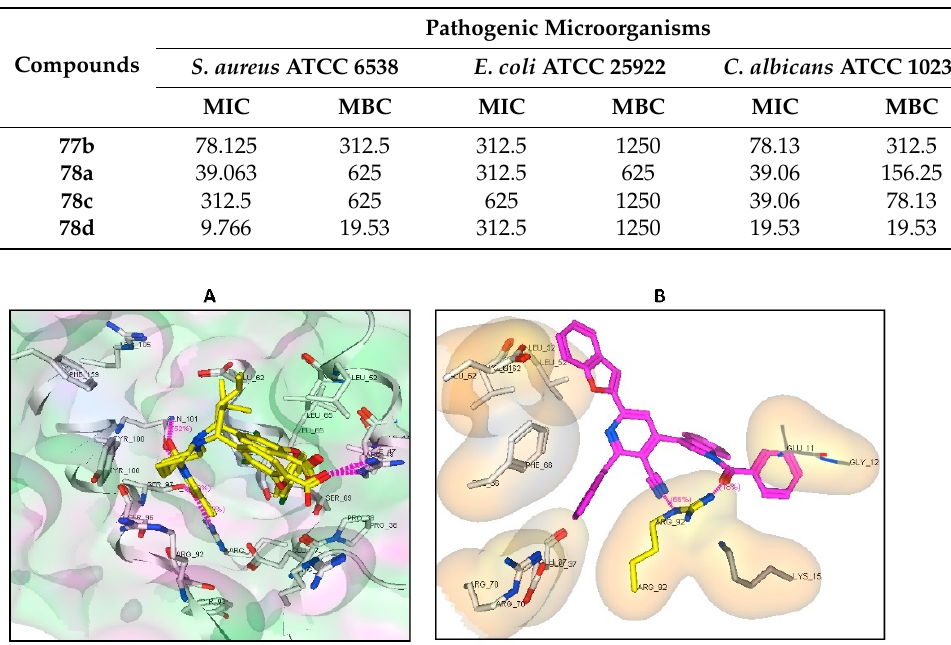
Table 3. Minimum inhibitory concentrations (MIC, µ g mL − 1 ) and minimum bactericidal concentra- tions (MBC, µ g mL − 1 ) of the most active bis(indolyl)pyridines [38].